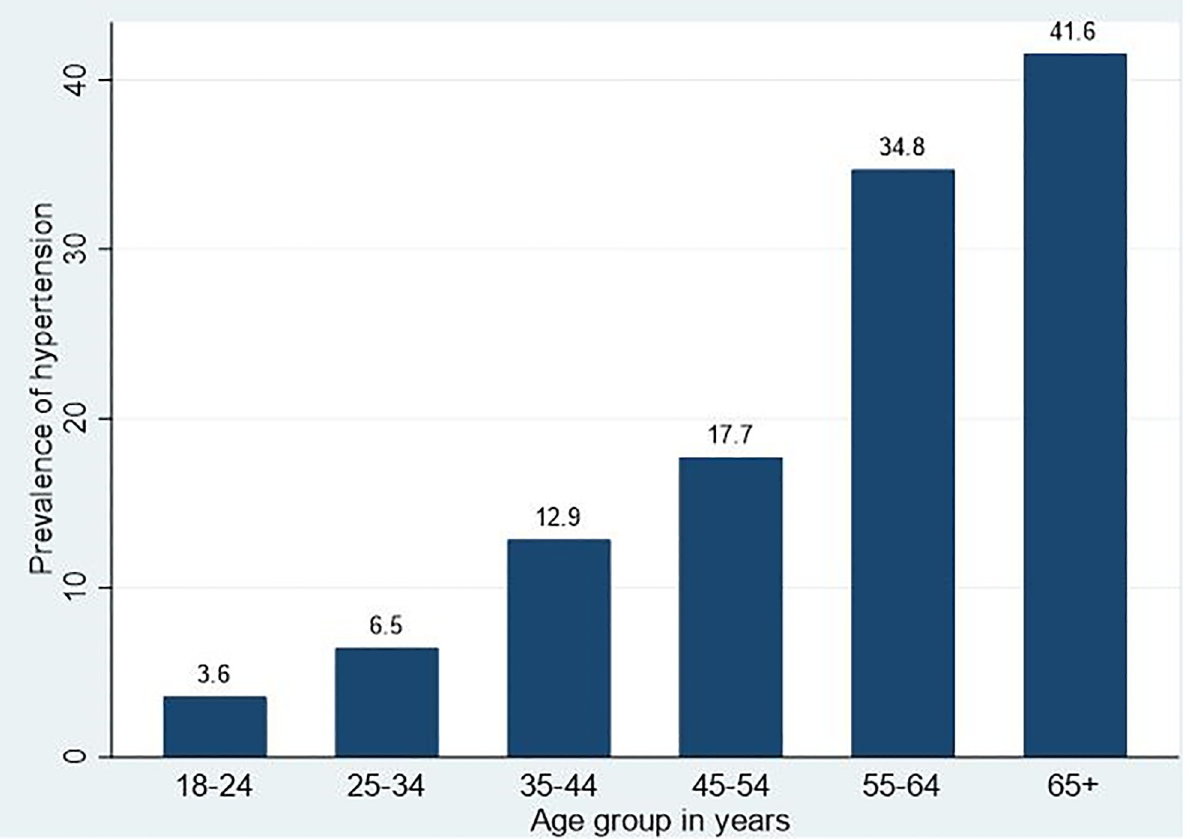
Fig 1. Prevalence of hypertension by age group in northwest Ethiopia,